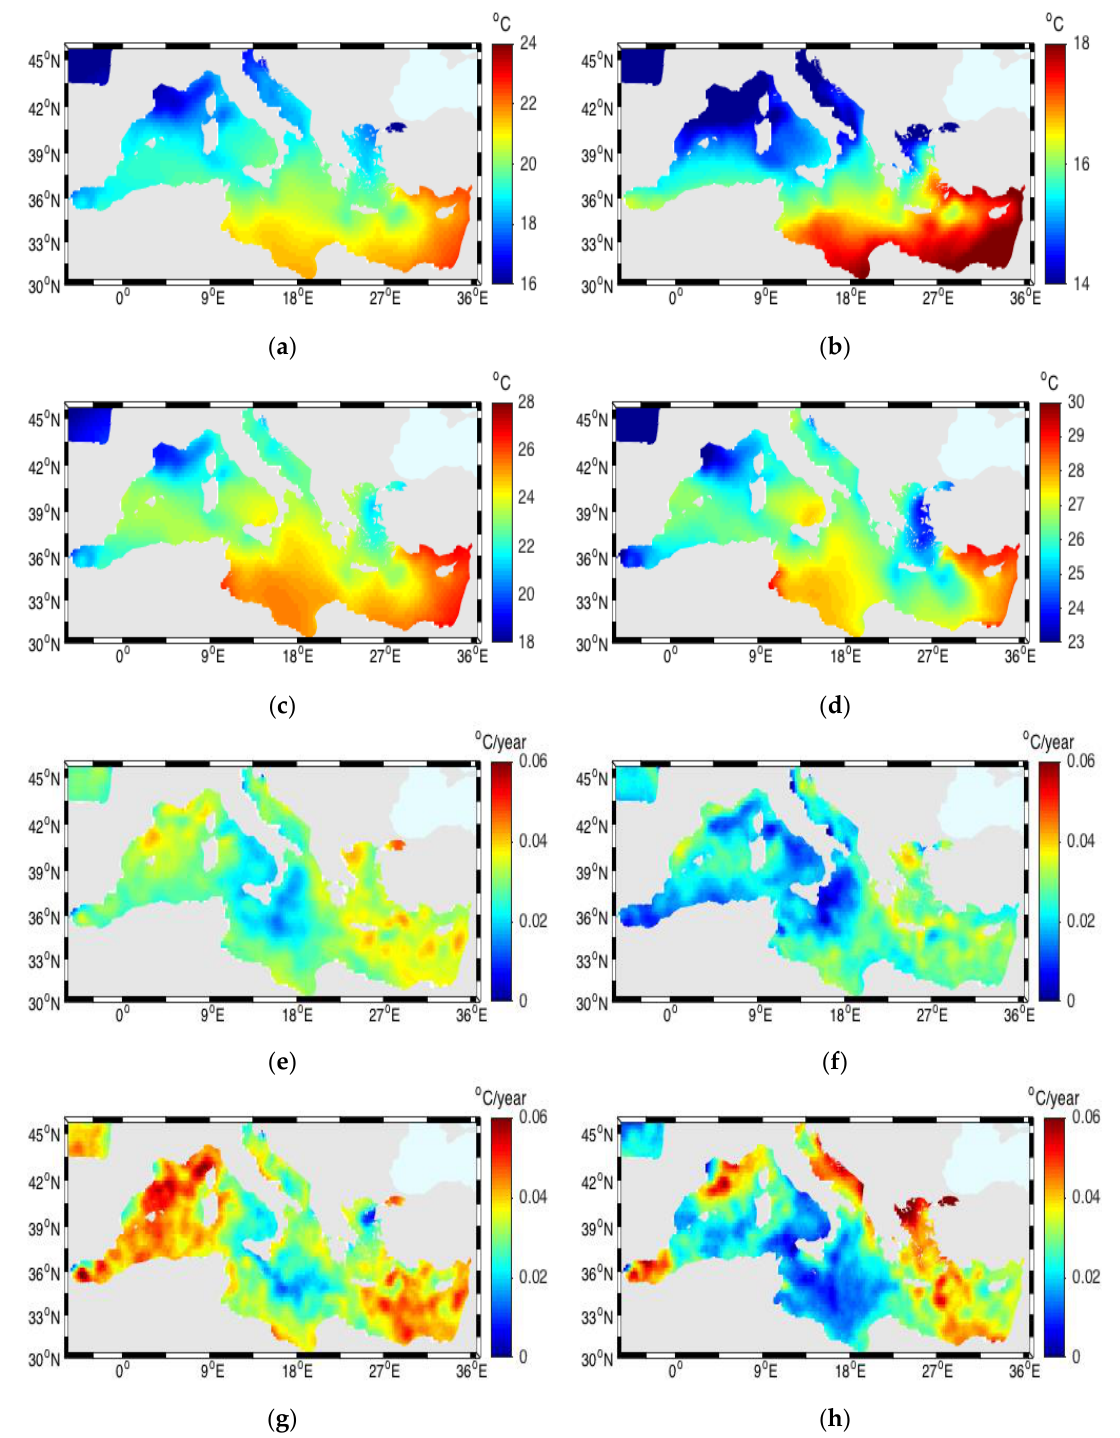
Figure 2. SST in the MEDIT based on the dOISST.v2 data set (1982–2017): ( a ) mean SST; ( b ) mean annual 25th percentiles of SST; ( c ) mean annual 75th percentiles of SST; ( d ) mean annual 98th percentiles of SST; ( e ) trends in the annual mean SST; ( f ) trends in the 25th percentiles; ( g ) trends in the 75th percentiles; ( h ) trends in the 98th percentiles. Trends are statistically significant ( p < 0.05, 95% confidence level). Time series of annually averaged SST data were used to estimate regional SST trends